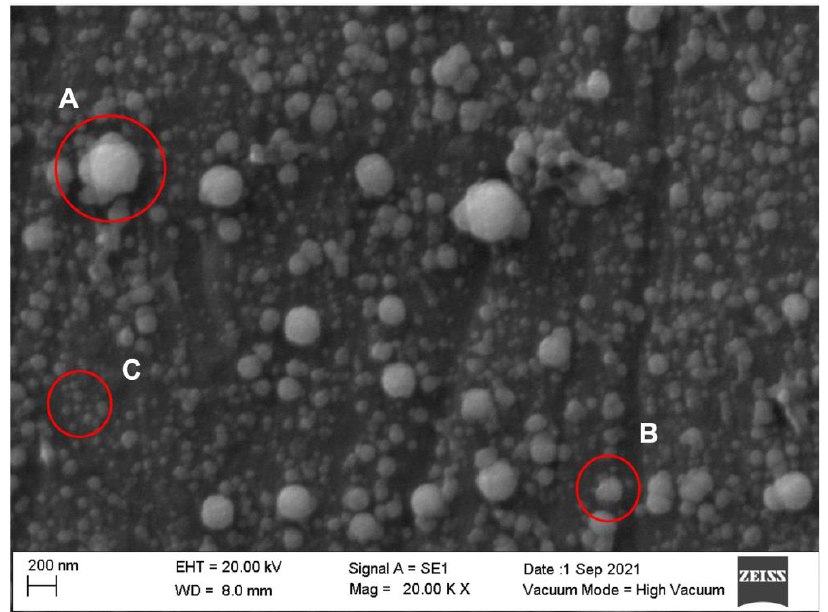
Figure 1. Scanning electron microscope micrograph of milk casein micelles treated at 600 MPa for 2 min. Examples of agglomeration ( A ), alteration to the shape ( B ) and micelle fragments ( C ).